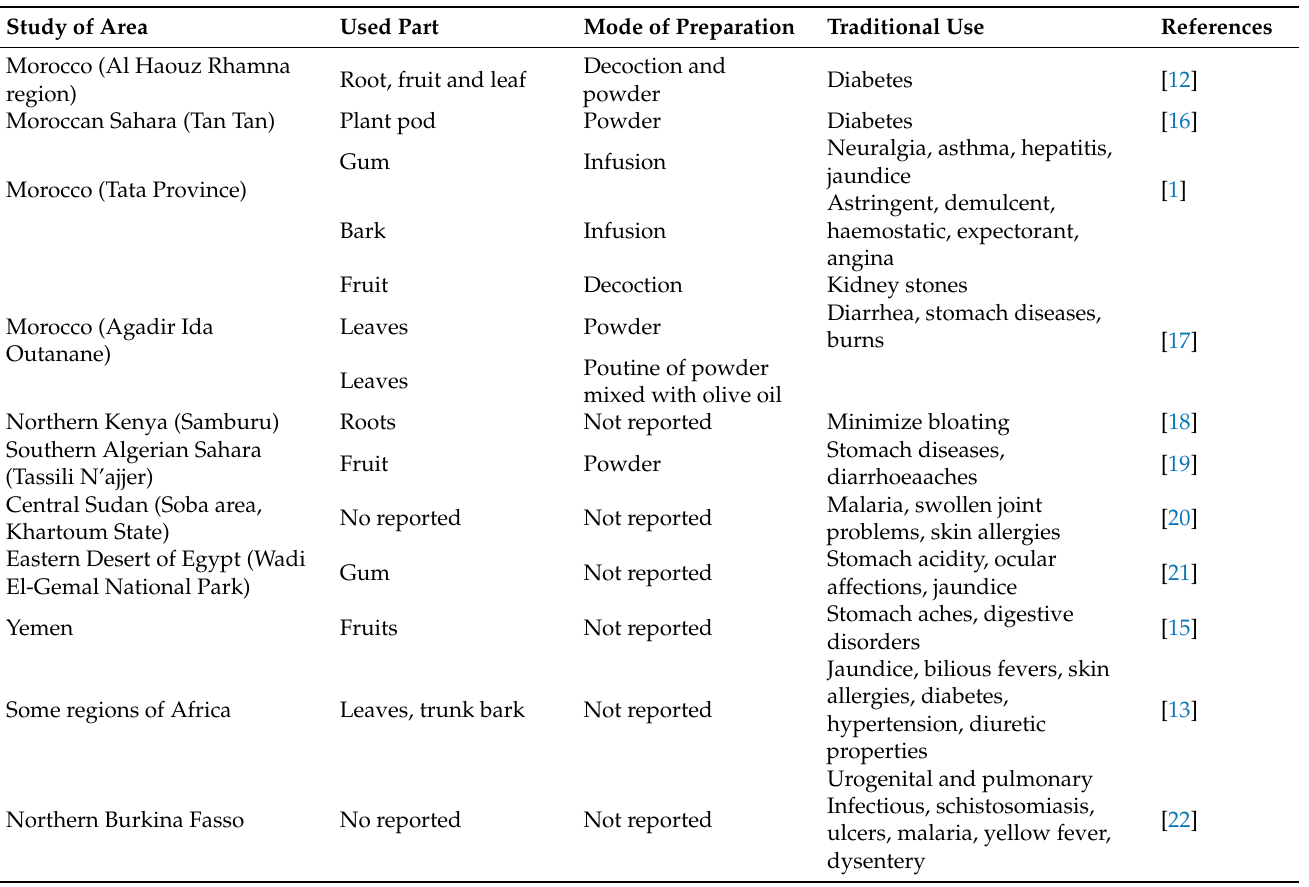
Table 1. Traditional uses of different parts of V. tortilis